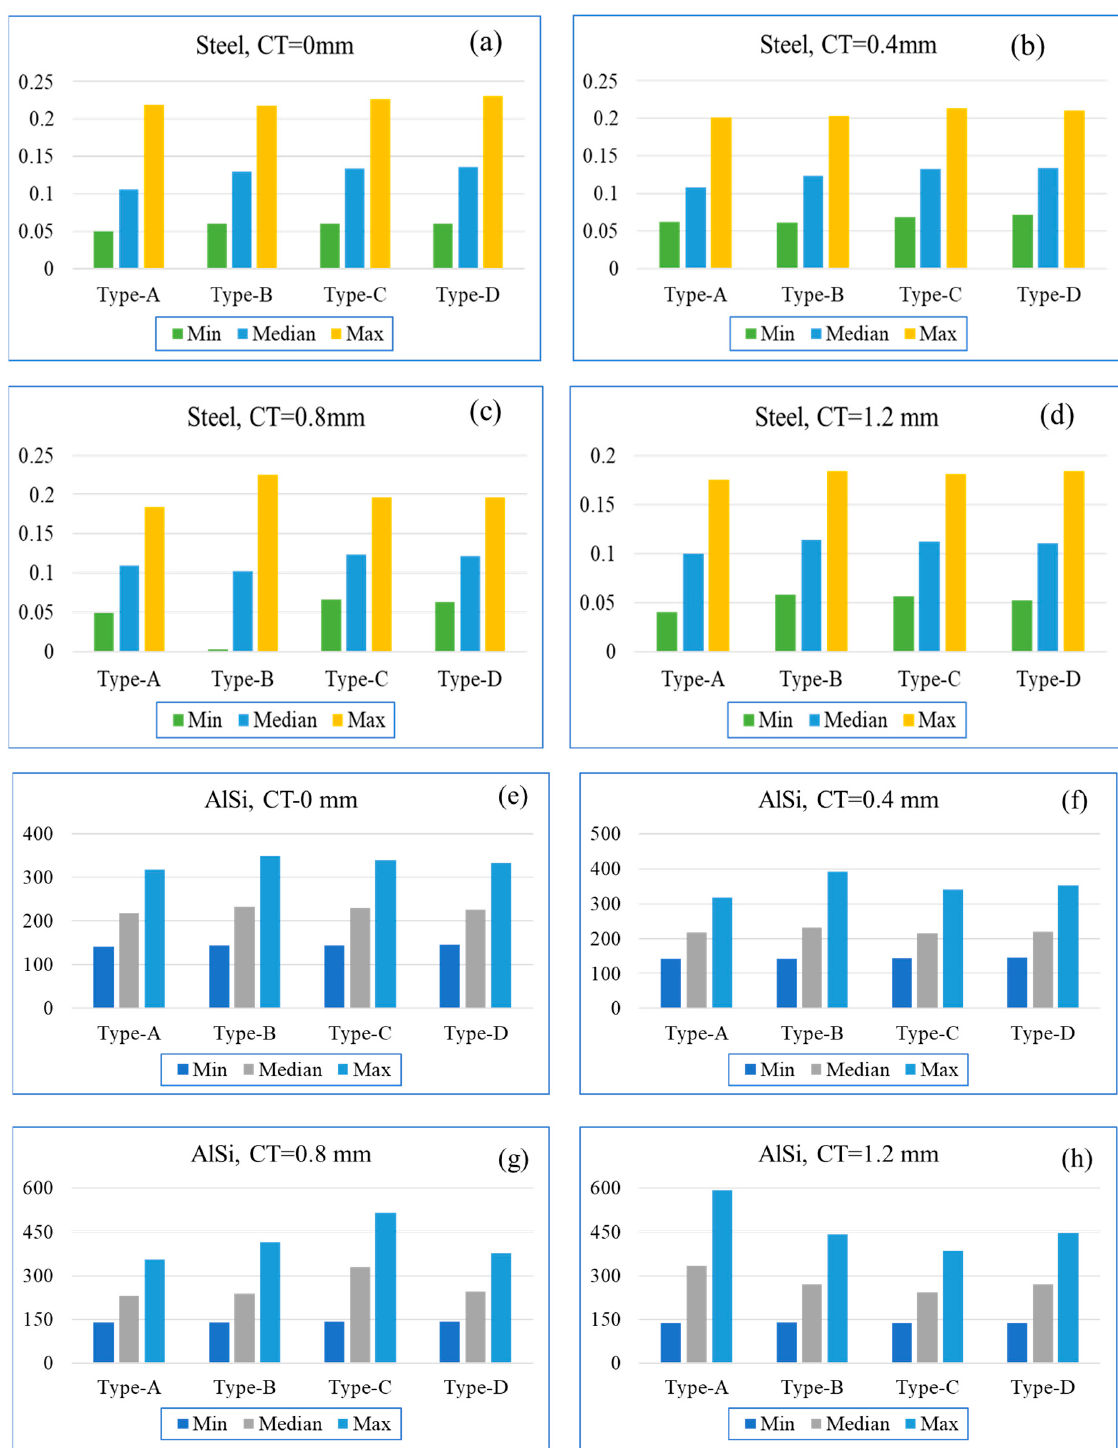
Figure 7. Bar chart of fuel carbon redundancy effect on energy influencing parameters: ( a ) temper- ature rise, ( b )back pressure variations, ( c )density variation, and ( d ) exhaust noise.